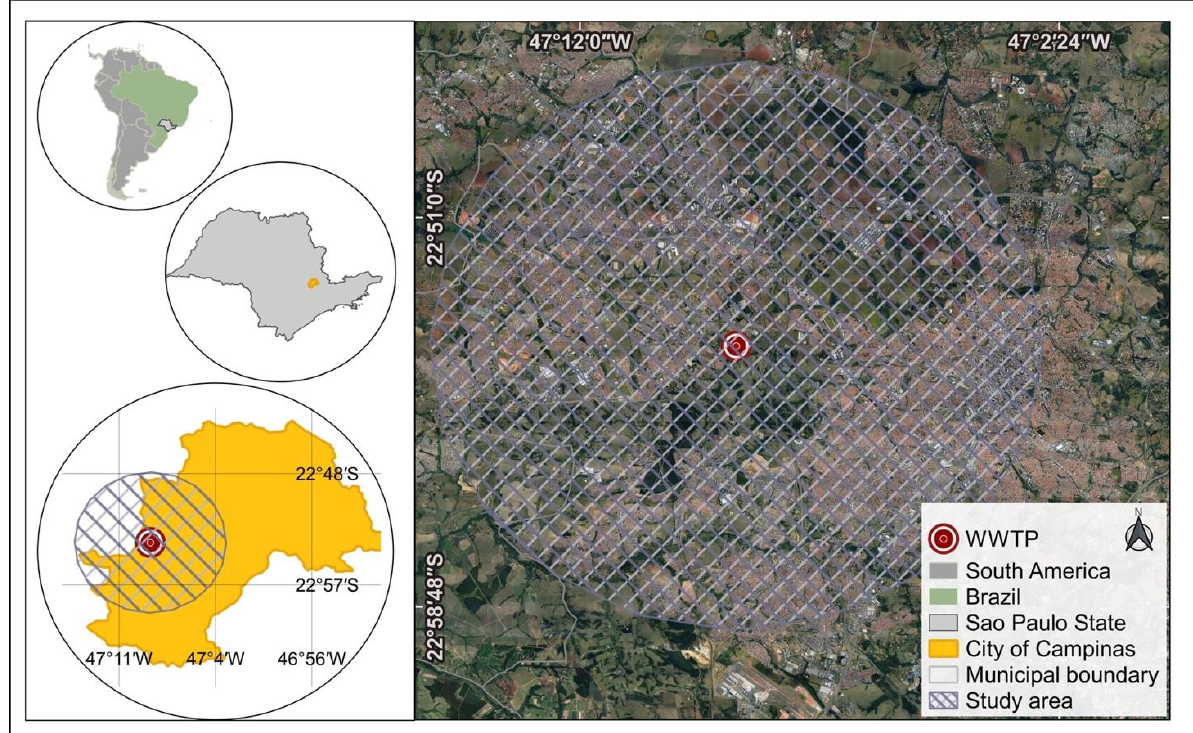
Figure 1. Geographic location of the considered